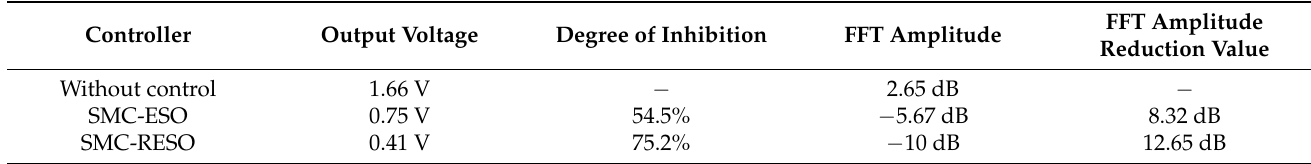
Table 2. Output amplitude of different